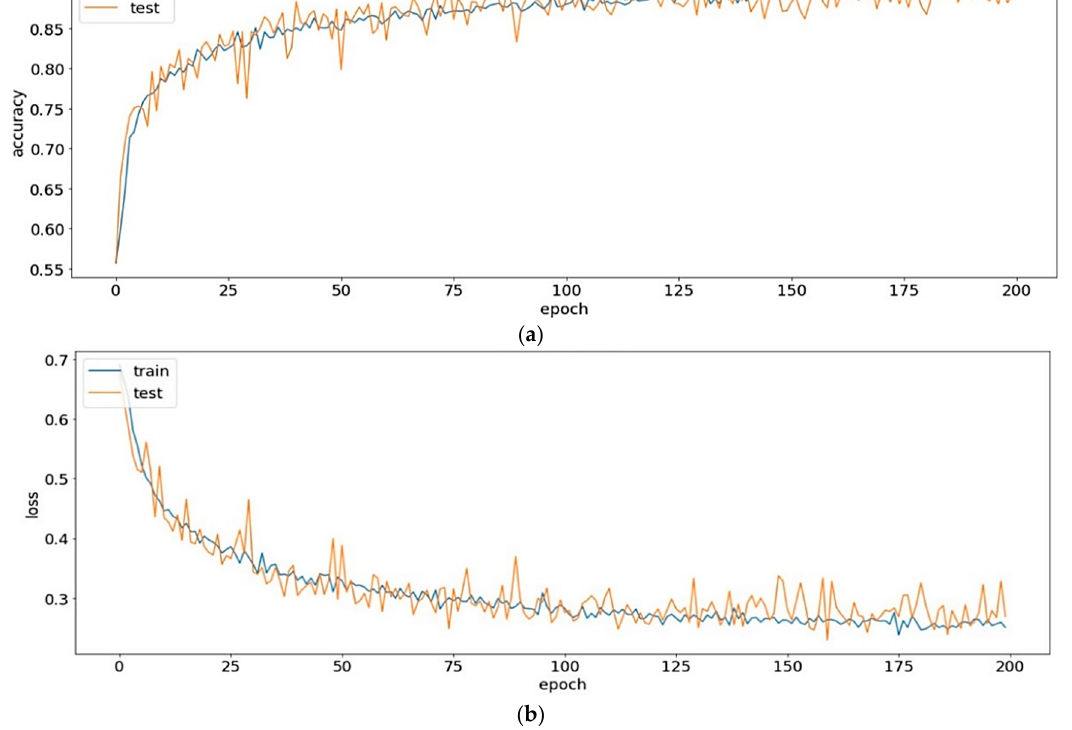
Figure 3. Evaluation of the model’s performance: ( a ) Model’s Accuracy; ( b ) Model’s